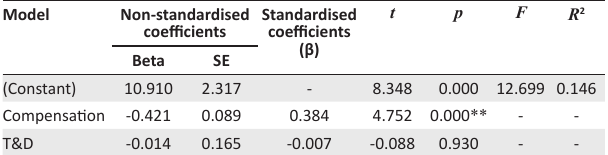
TABLE 5: Compensation and training and development as predictors of organisational citizenship